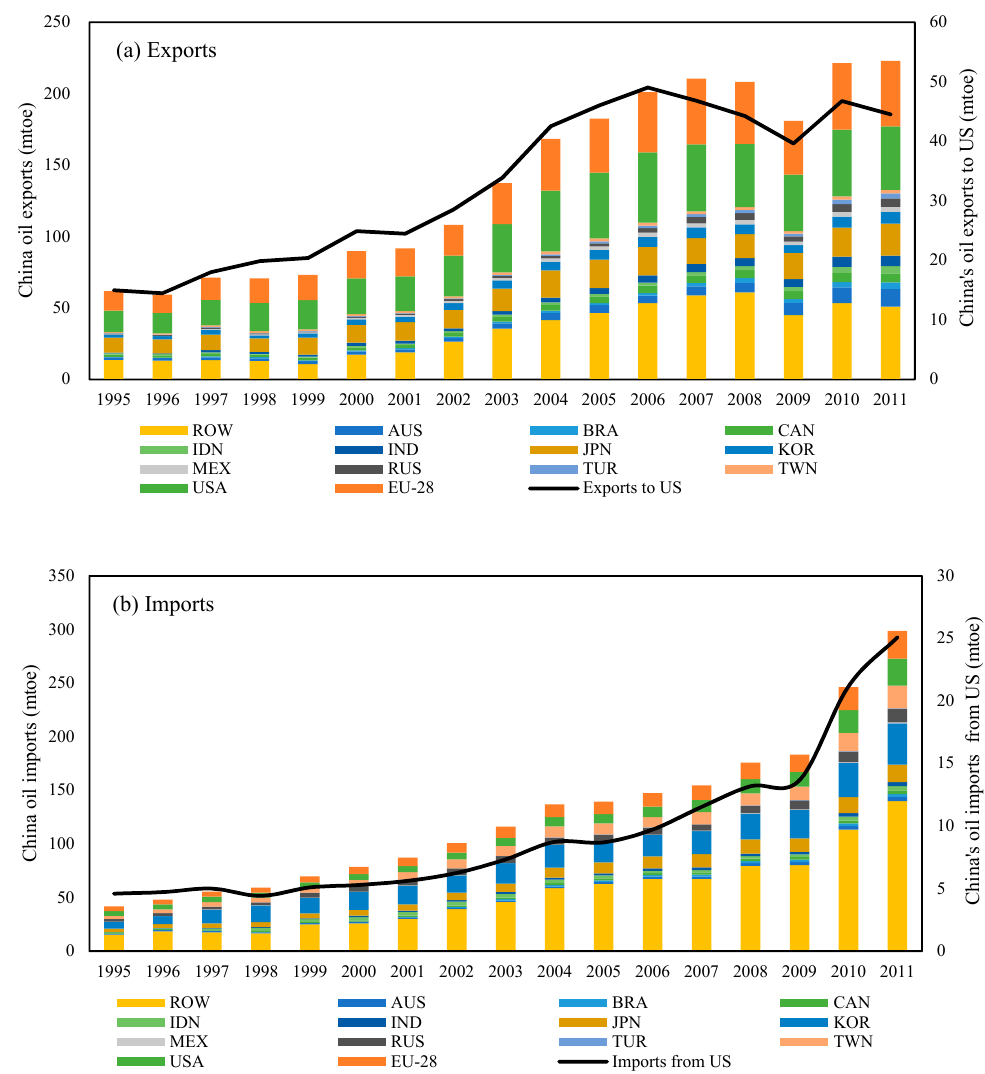
Figure 3. The evolution of China’s virtual oil consumption: ( a ) Exports; ( b ) Imports.